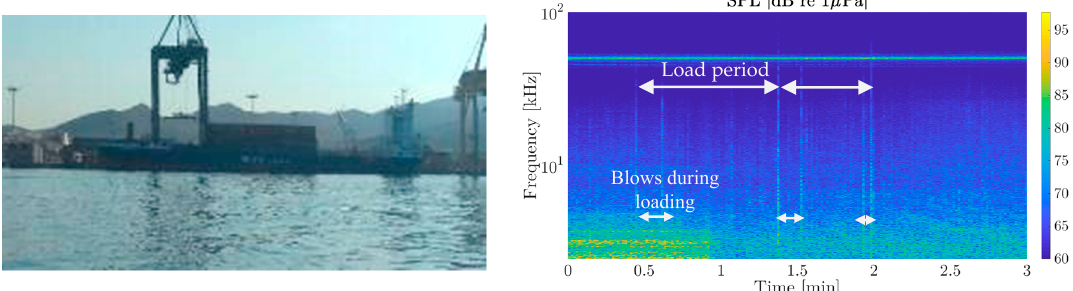
Figure 10. Loading a cargo ship ( left ), and spectrogram of the noise generated ( right ) at P2 in Figure 4. Figure 9. ( left ) Spectrum of continuous noise source. ( right ) Its spectrogram (Point P3).